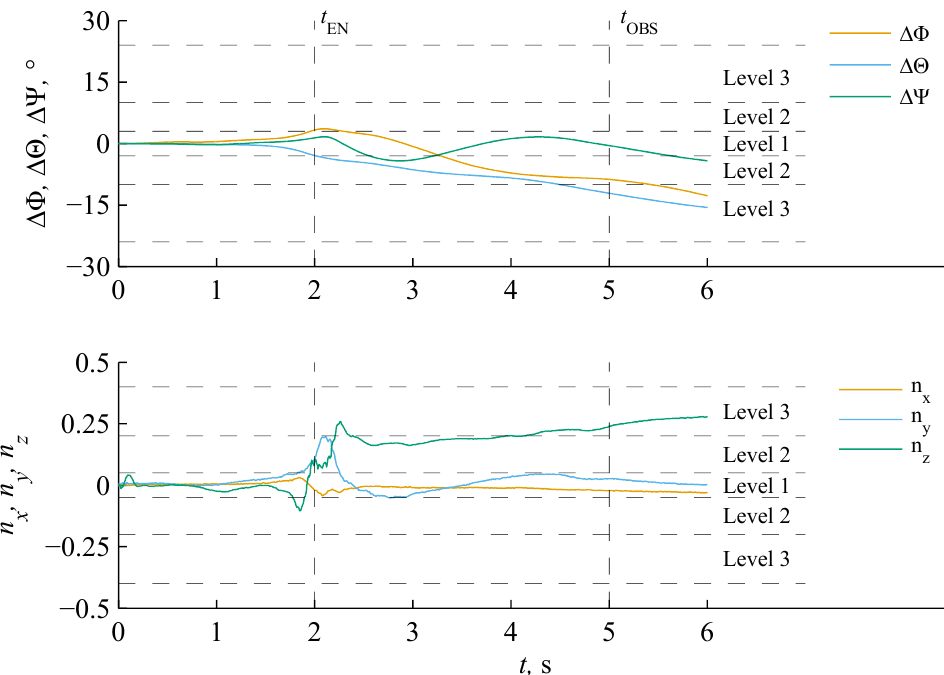
Figure 18. Attitude changes ( ∆Φ , ∆Θ , ∆Ψ ) and load factors ( n x , n y , n z ) for the non-piloted simulation of C1 at position 2 with limits of ADS-33 offline criteria.